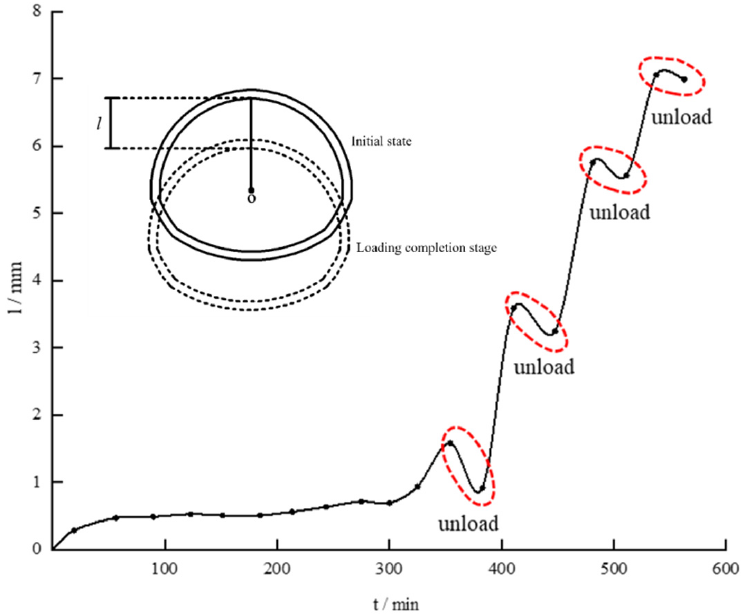
Figure 6. Tunnel deformation reflected by the site change of laser cross site.